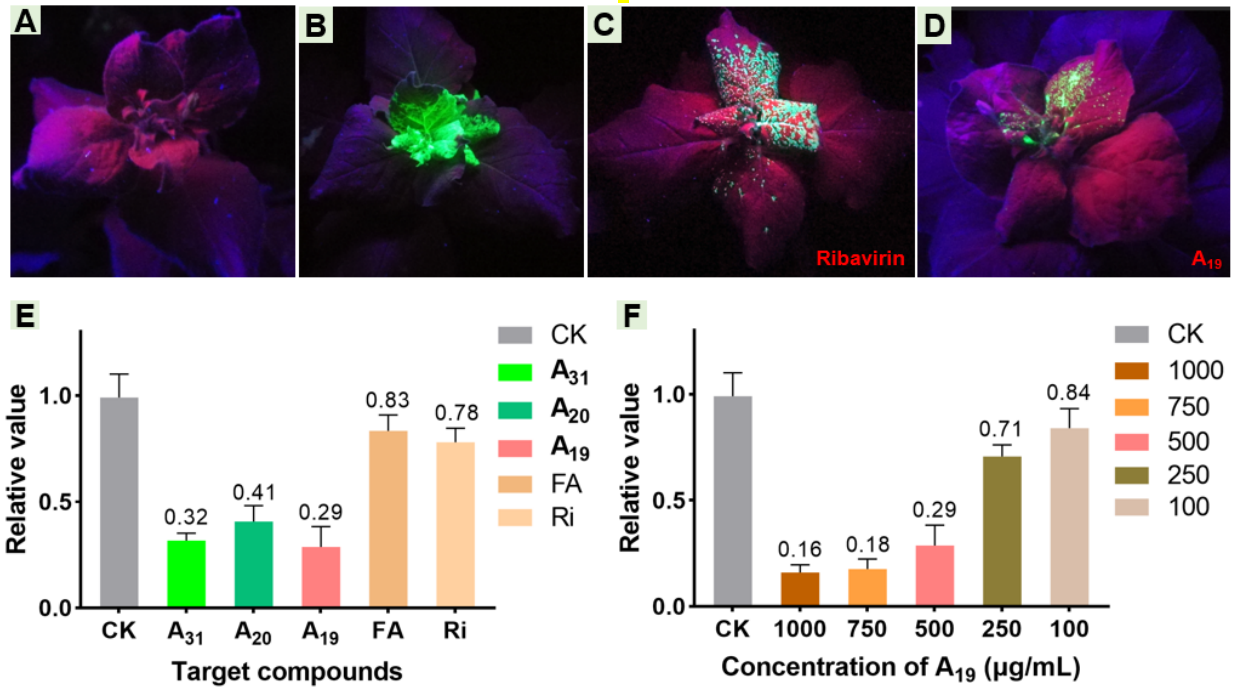
Figure 11. Inhibition effects of A 19 and Ri on the spread of TMV in N. benthamiana: leaves injected with 1% DMSO ( A ), TMV ‐ GFP ( B ), TMV ‐ GFP containing 0.25 mM Ri ( C ), or TMV ‐ GFP